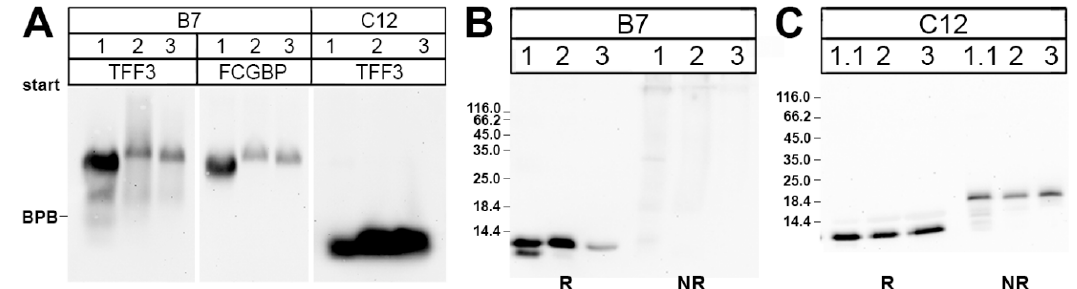
Figure 2. Analysis of high- and low-molecular-massfractions of human saliva of three individuals after SEC on Superdex 75 HL column. ( A ) 1% AgGE and subsequent Western blot analysis of the high- (B7) and low-molecular-mass fractions (C12), respectively, of the individuals 1–3. Shown are the reactivities for TFF3 and FCGBP, respectively. The dye bromophenol blue (BPB) is marked on the left. ( B ) 15% SDS-PAGE and subsequent Western blot analysis of the high-molecular-mass fractions B7 (after SEC on a Superdex 75 HL column) of the same three individuals as in (A). Samples were analyzed under reducing (R) and non-reducing conditions (NR), respectively, for their TFF3 immunoreactivity. The molecular mass standard is indicated on the left. ( C ) 15% SDS-PAGE and subsequent Western blot analysis of the low-molecular-mass fractions C12 analogous to (B).